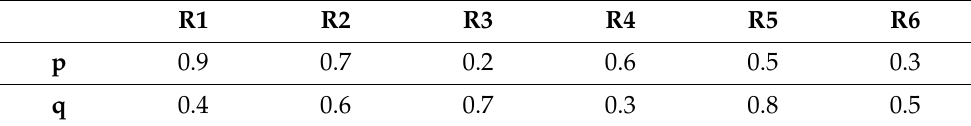
Table 4. Energy ( p ) and Latency ( q ) for each routing mechanism in Case